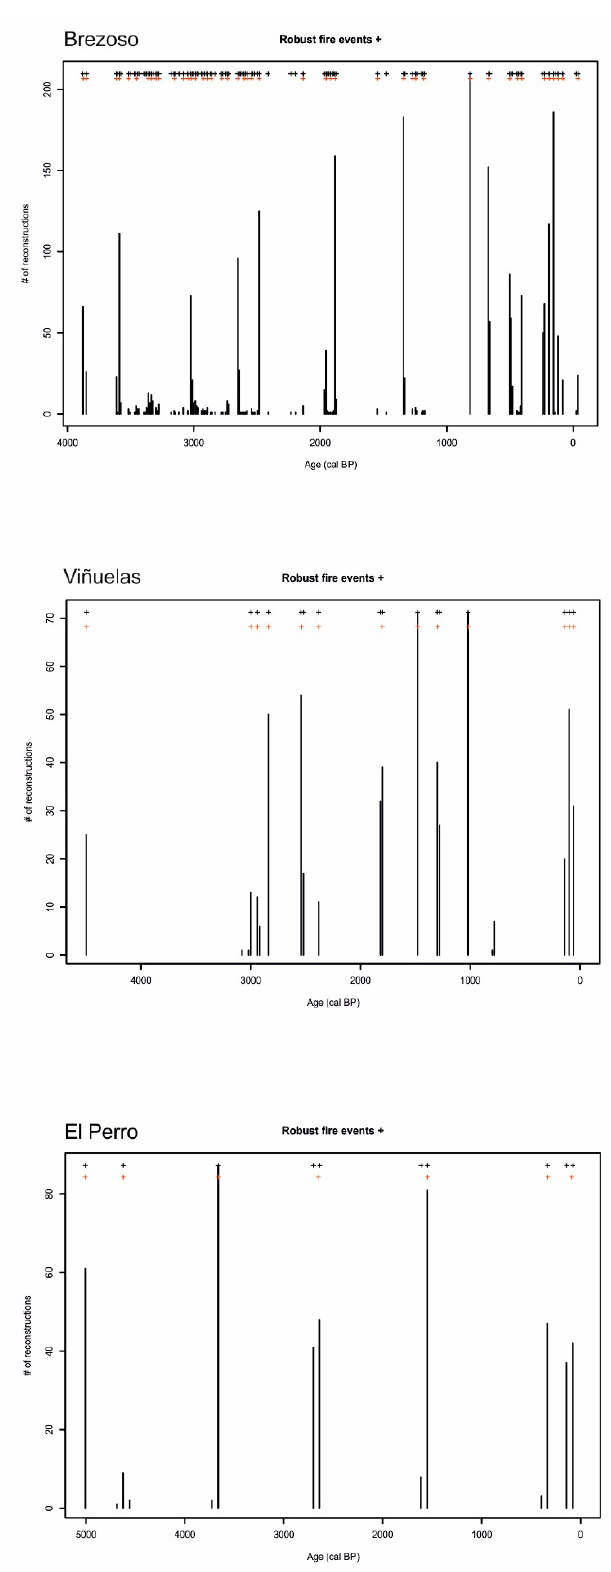
Figure A2. Fire densities and Robust Fire Events in the selected mires (red crosses): Brezoso, Viñuelas, El Perro.